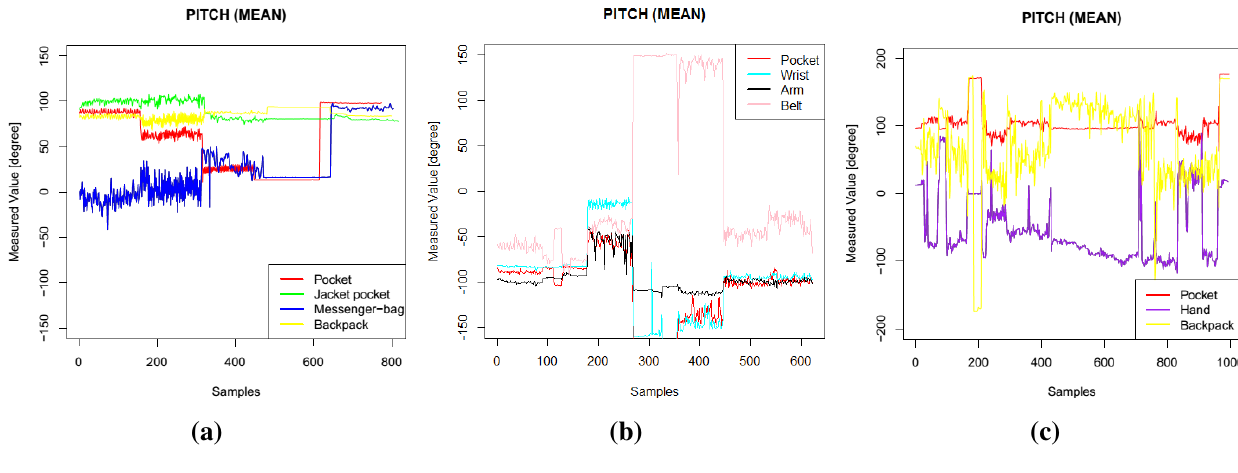
Figure 1. Pitch features. ( a ) Dataset 1; ( b ) Dataset 2; ( c ) Dataset 3.